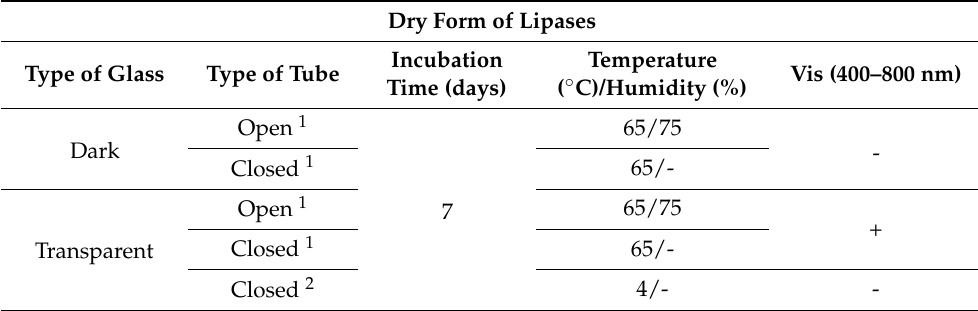
Table 3. The storage conditions of immobilized CALB and CRL-OF in dry form in the climatic chamber and in the